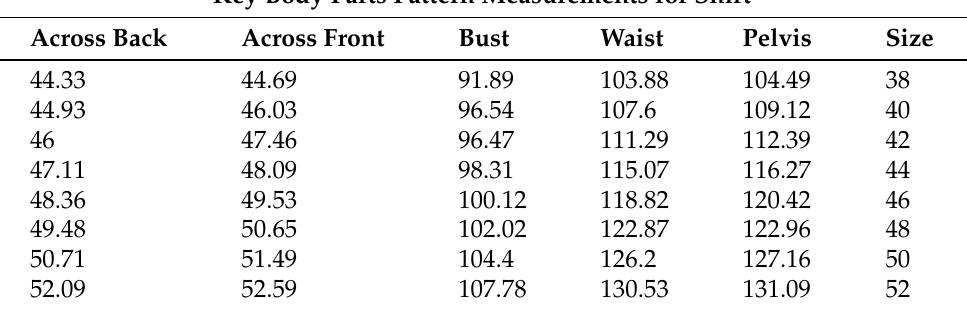
Table 8. Pattern measurement for key body part’s of shirt.